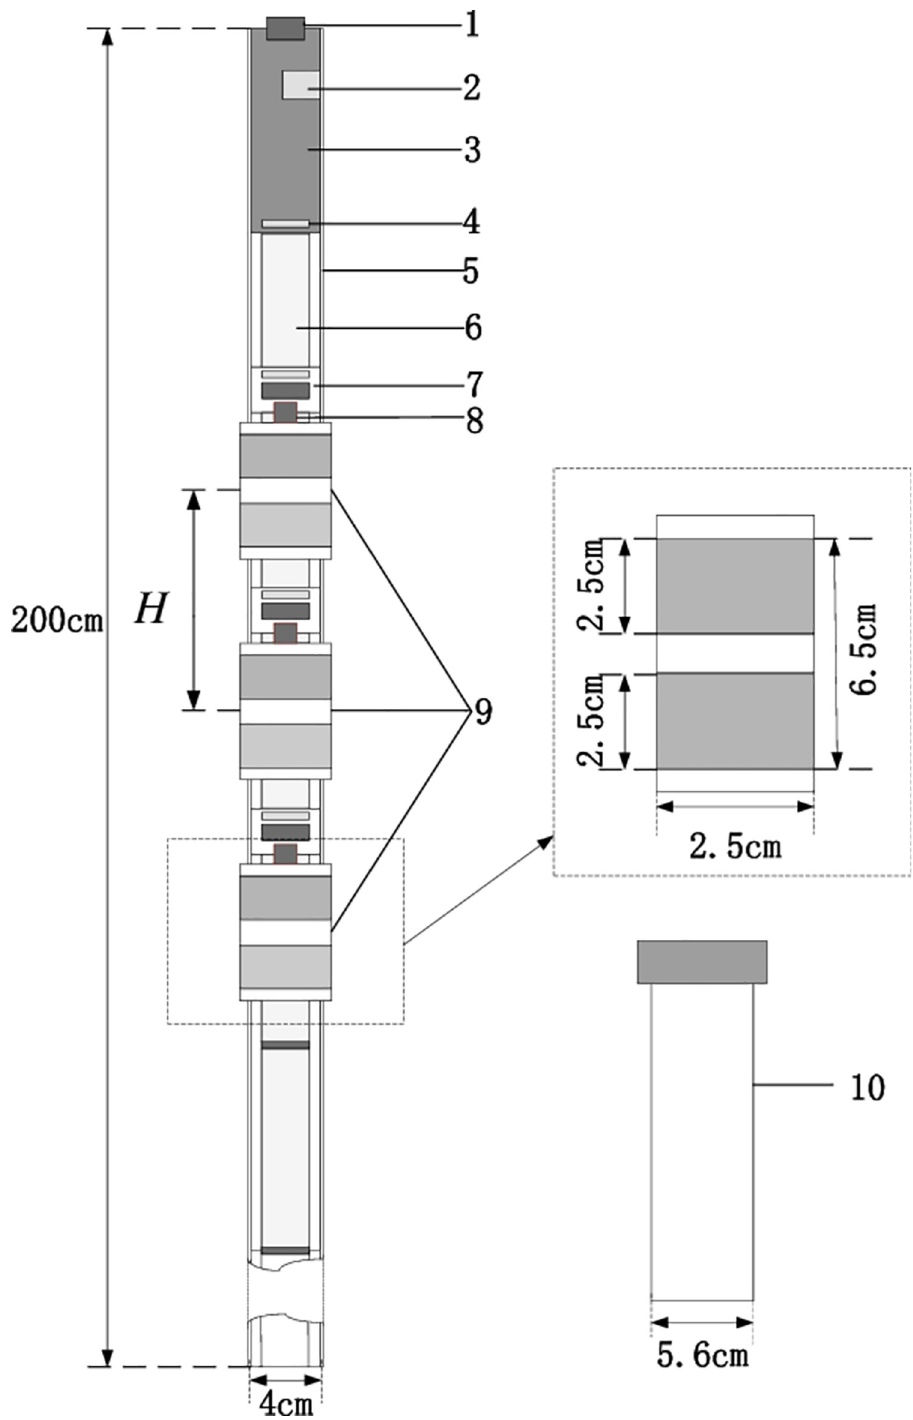
Fig 6. Schematic of soil freezing and thawing sensor [41]. H. Spacing of sensor probe (The shortest distance was 10cm) 1. Communication interface of power supply and RS485 2. SD card storage module 3. Sensor collecting mainboard 4. Bottomed cable connector 5. PVC support frame 6. Connecting cables 7. Temperature sensor board 8. Moisture and temperature mainboard connector 9. Copper detection probe 10.PVC tube.